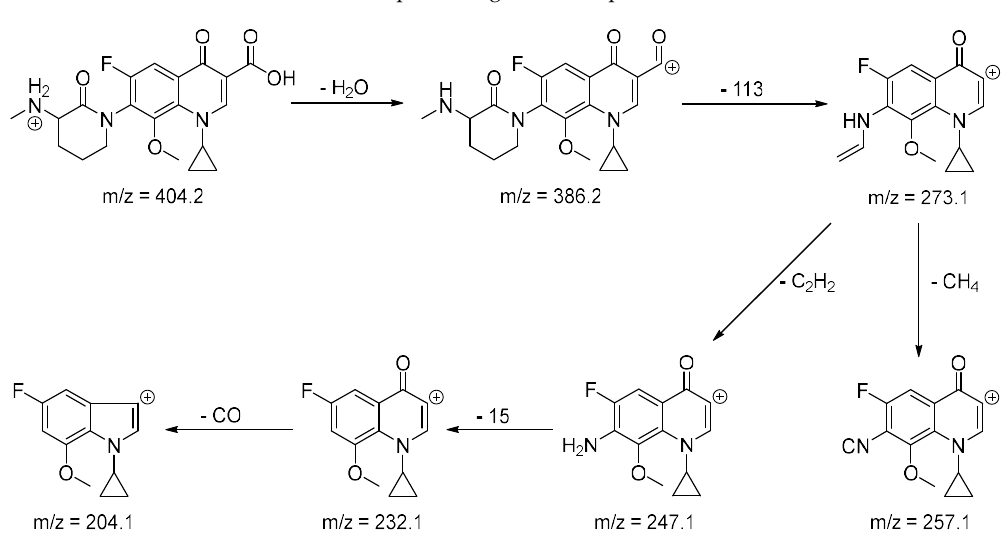
Scheme 1. Proposed fragmentation pattern of BAL.